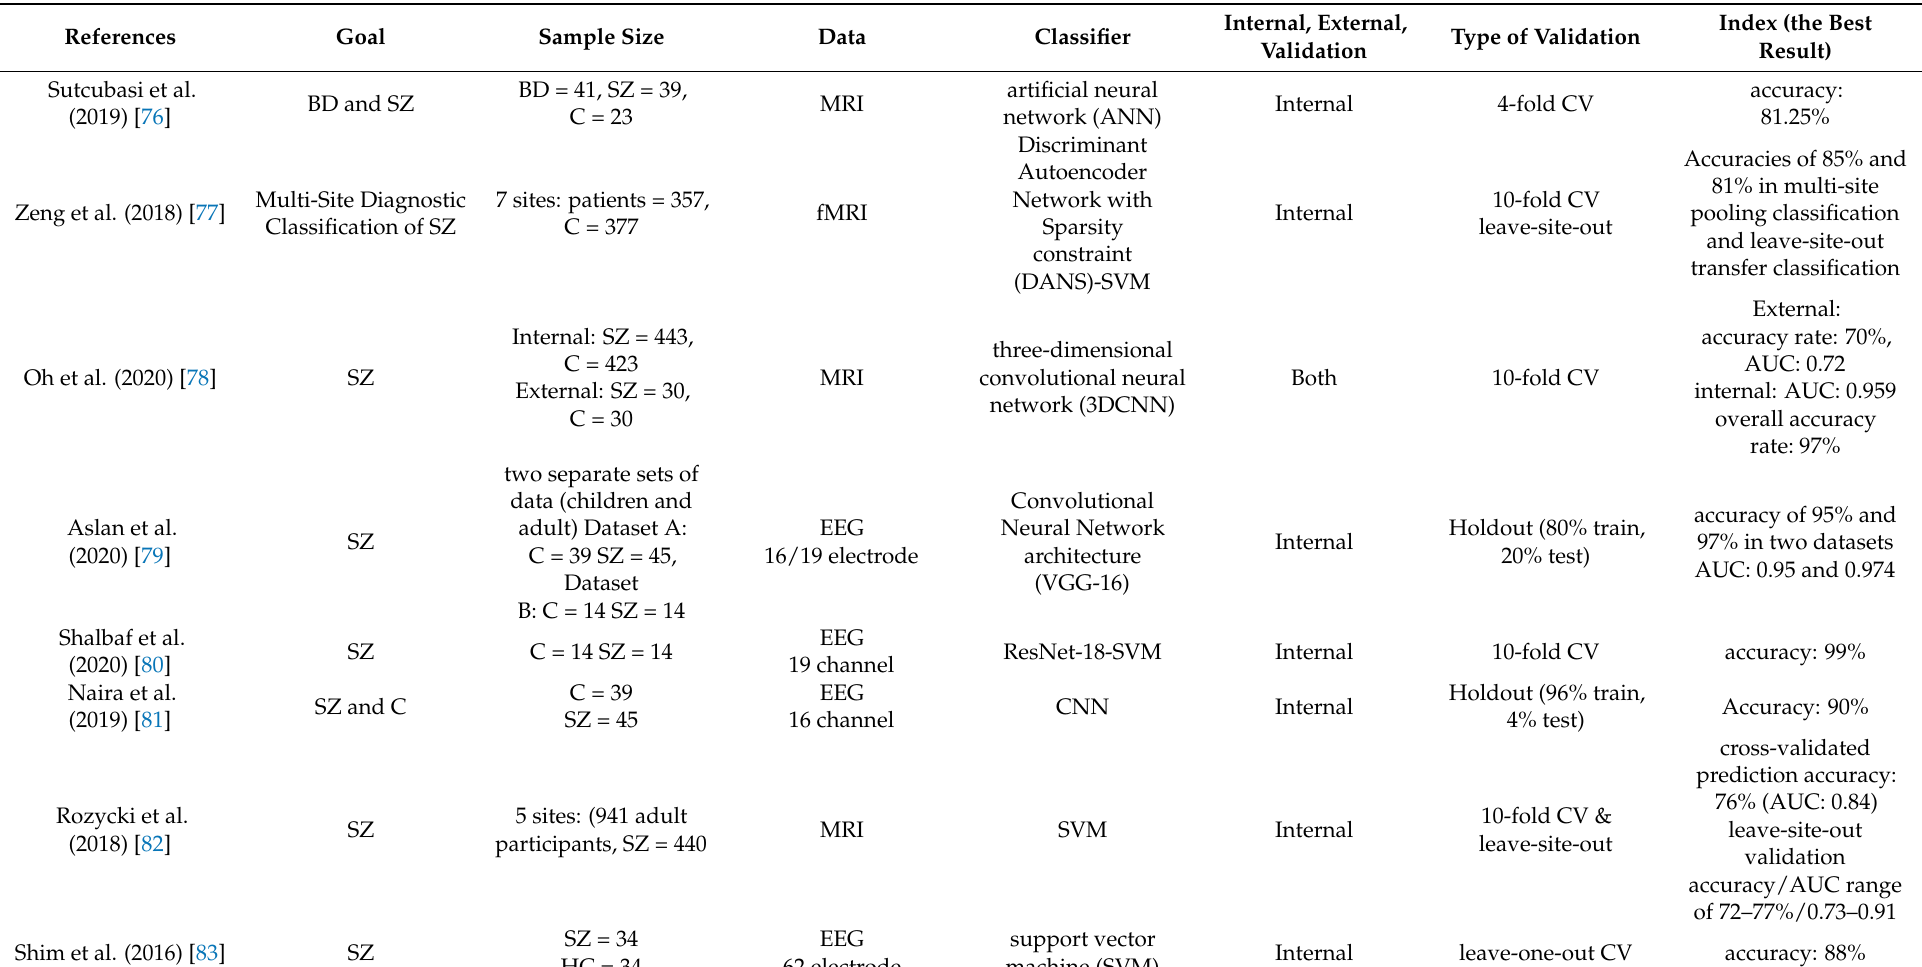
Table 3. CAD methods for mental and neurological disorders